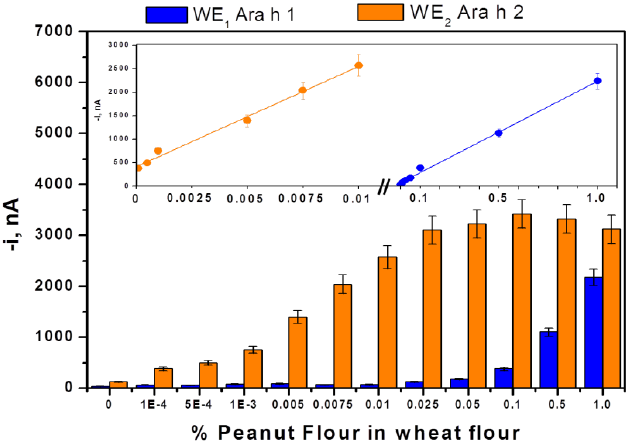
Figure 6. Amperometric responses obtained with the dual MBs-based immunosensing platform for extracts prepared from wheat flour spiked with increasing amounts of peanut flour (final concentrations: 0.0001%, 0.0005%, 0.001%, 0.005%, 0.0075%, 0.01%, 0.025%, 0.05%, 0.1%, 0.5% and 1.0% ( w / w )). Error bars estimated as triple the standard deviation ( n = 3).